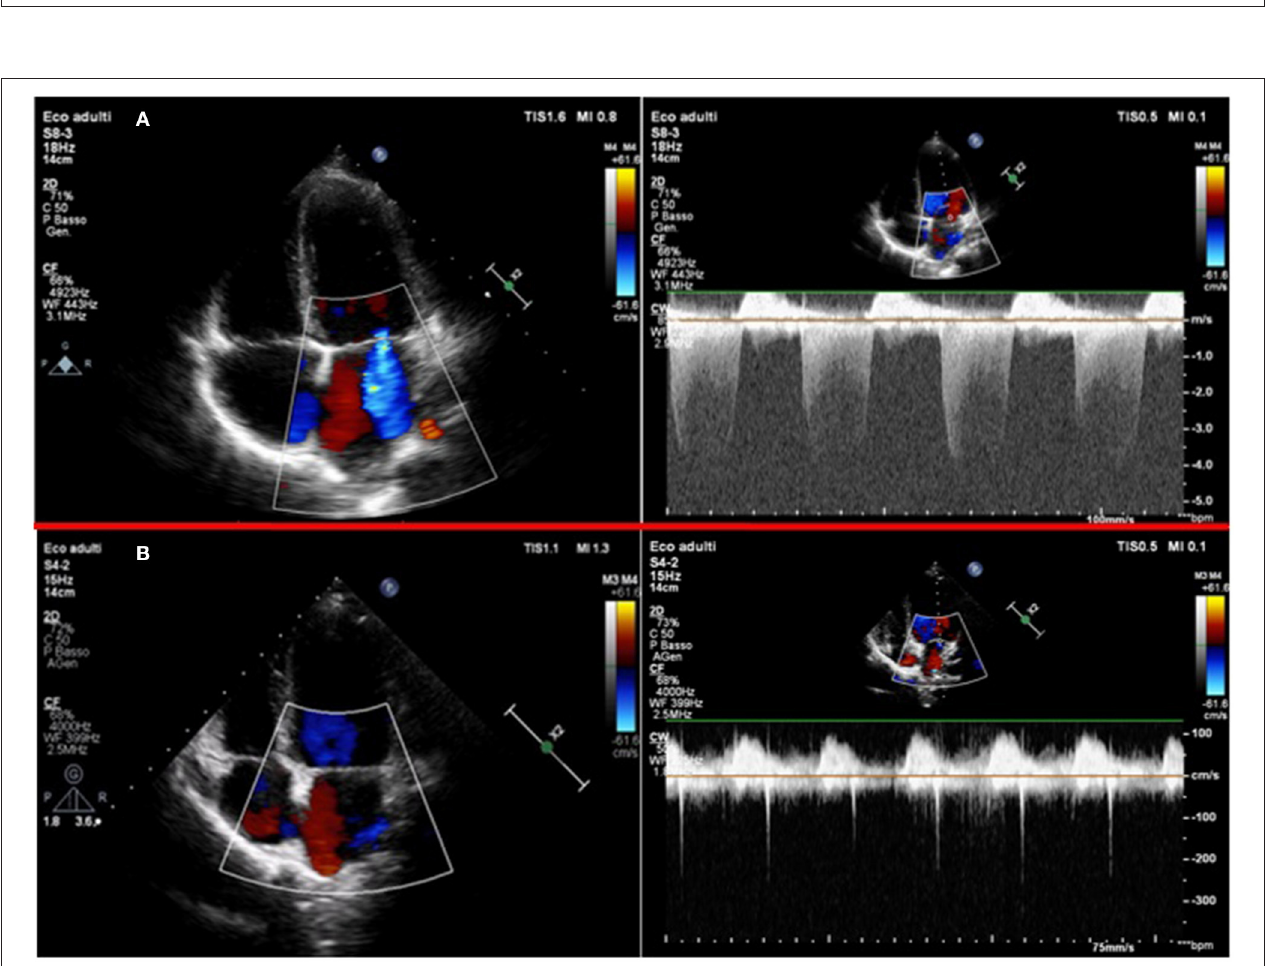
FIGURE 3 | (A) 2-D Color-Doppler echocardiography of the first patient in the acute phase: left panel shows the apical 4 chambers view with color flow Doppler, showing a moderate mitral regurgitation; right panel shows the continuous wave Doppler of the mitral regurgitant jet. (B) 2-D Color-Doppler echocardiography of the same patient 1 month after: left panel shows an apical 4 chambers view with color flow Doppler and right panel shows the continuous wave Doppler of the minimal mitral regurgitation.